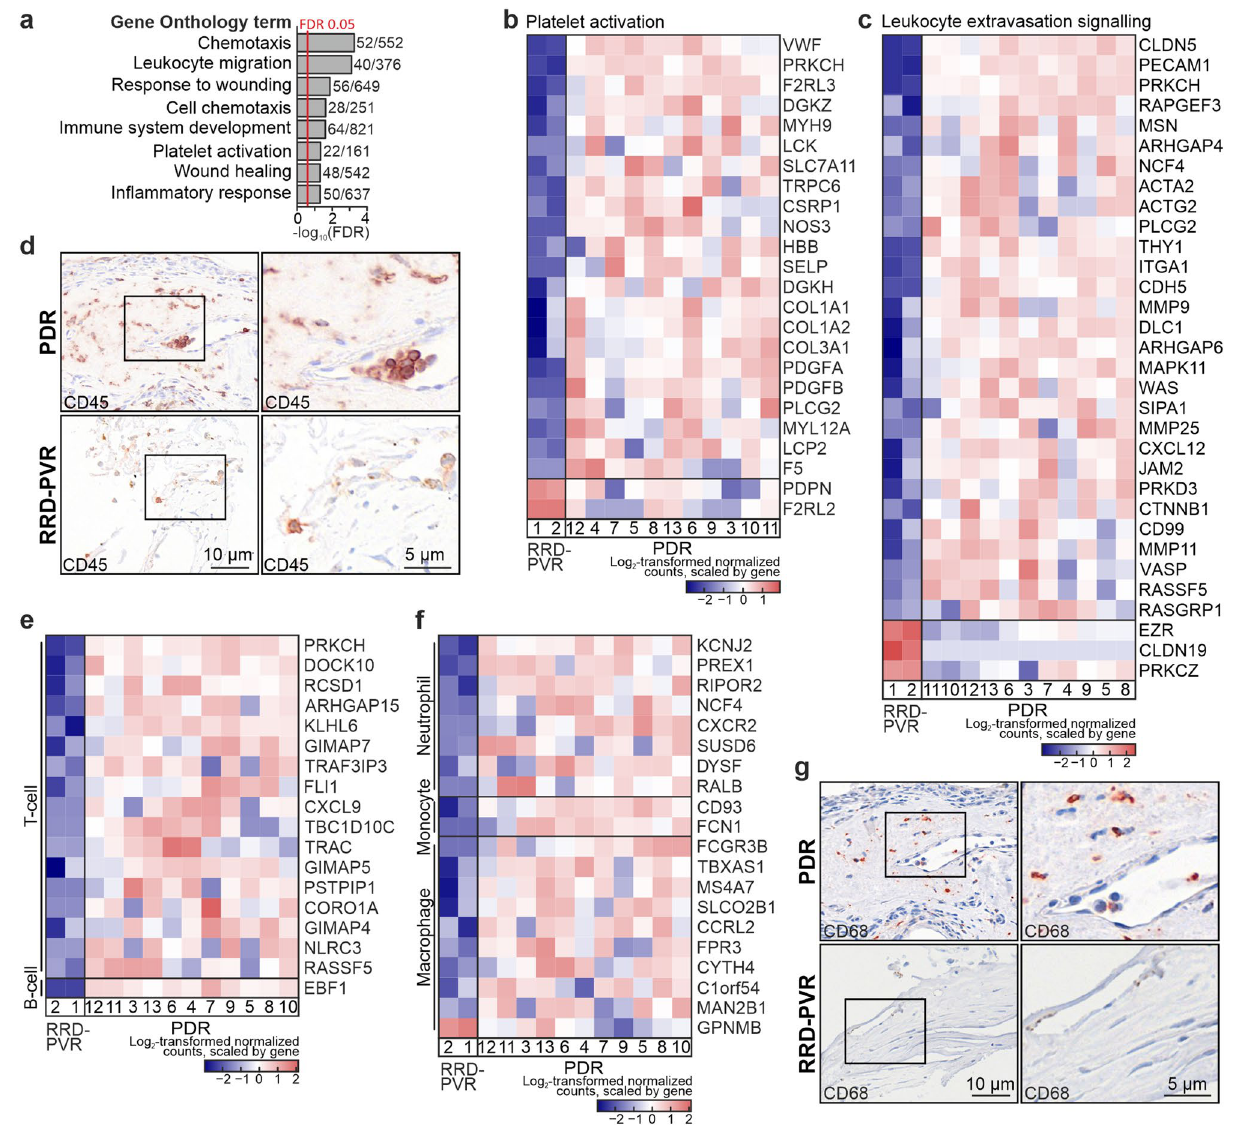
Figure 6. Inflammation and wound healing are involved in PDR and RRD-PVR. ( a ) Bar chart showing GO-terms related to inflammation and wound healing, based on the DEGs upregulated in PDR. Numbers beside bars indicate number of DEGs in GO-term versus the total number of genes in the GO-term. ( b ) Heatmap of log 2 -transformed normalized read counts of DEGs in GO-term Platelet activation . ( c ) Heatmap of log 2 -transformed normalized read counts of DEGs in IPA canonical pathway Leukocyte extravasation signalling. ( d ) Representative light micrographs of immunohistochemistry for CD45 in excised PDR and RRD-PVR tissue. ( e–f ) Heatmap of log 2 -transformed normalized read counts of DEGs in T-cell and B-cell signatures ( e ), and in macrophage, monocyte, and neutrophil cell signatures ( f ). ( g ) Representative light micrographs of immunohistochemistry of CD68 in PDR and RRD-PVR tissue. Scale bars, 10 µm (left), 5 µm (magnified